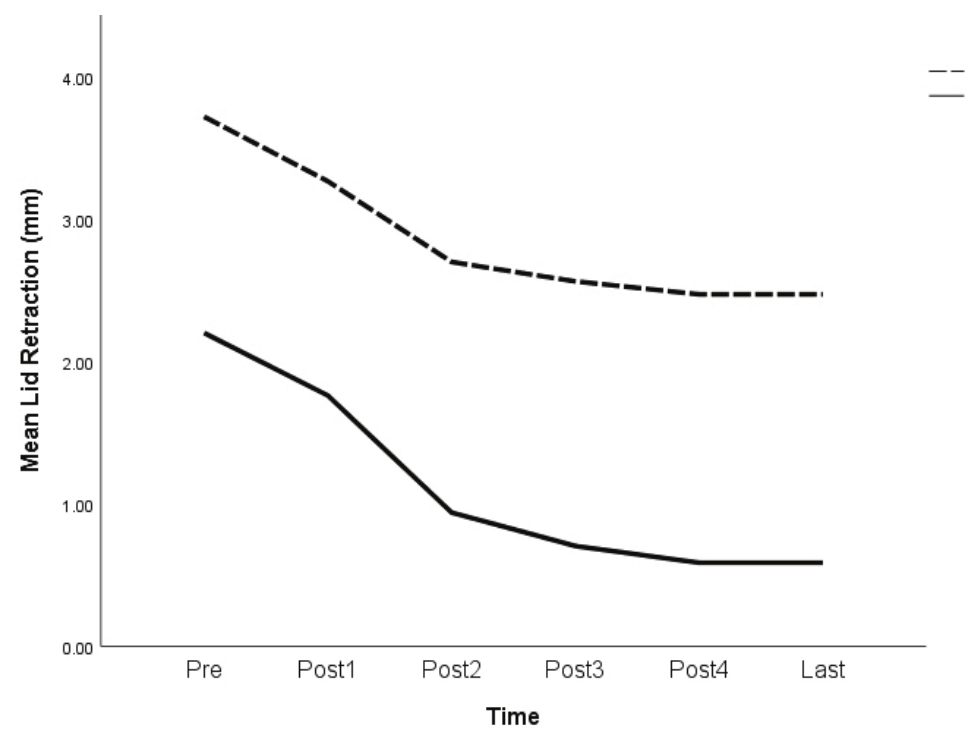
Figure 2. Line diagram of changes in mean lids retraction before the injections up to the last